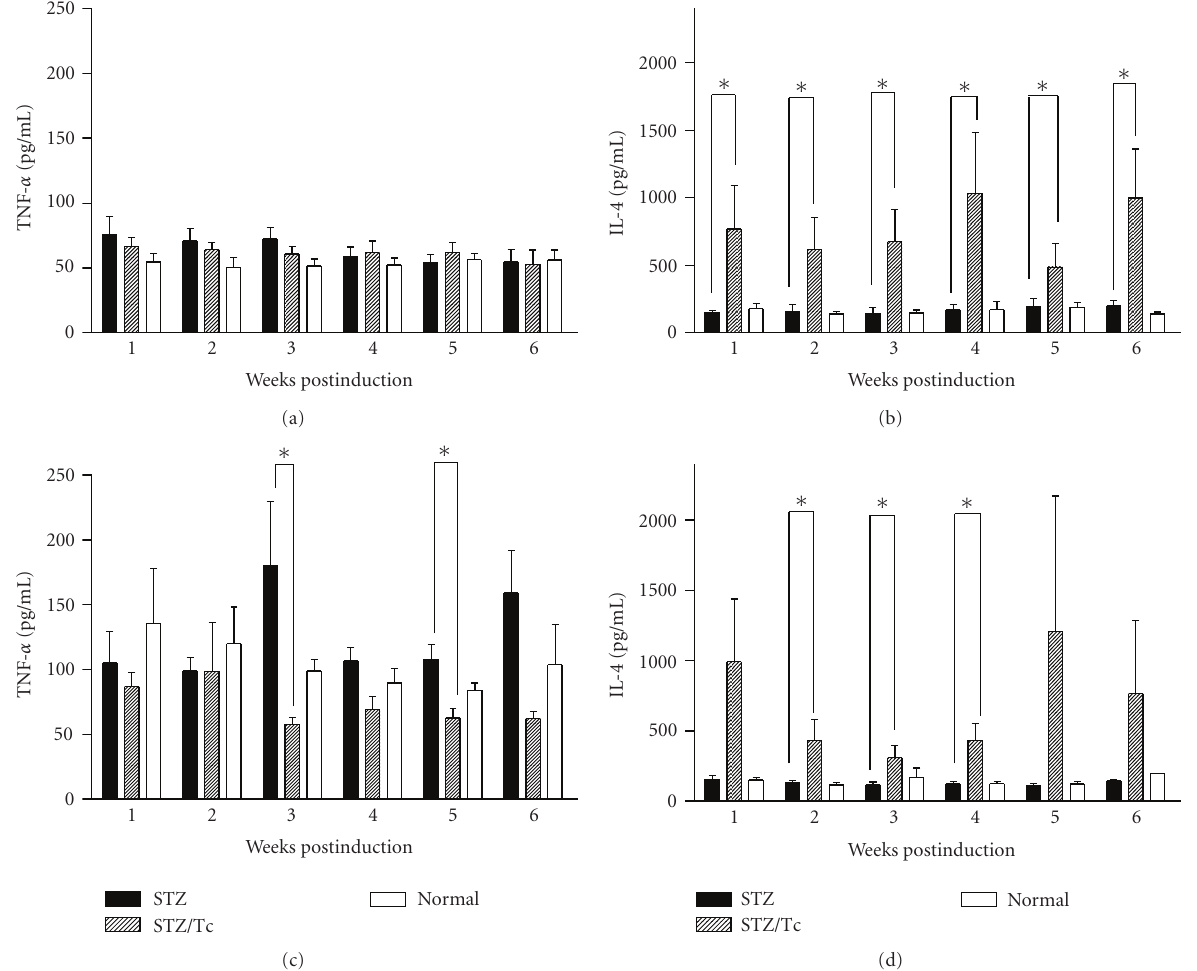
Figure 5: Cytokine profiles from the sera of mice treated with MLDS. BALB/c mice were bled at indicated time points and (a) TNF- α and (b) IL-4 were detected by ELISA. (c) TNF- α and (d) IL-4 for C57BL/6 mice. ∗ P < . 05, n = 10.